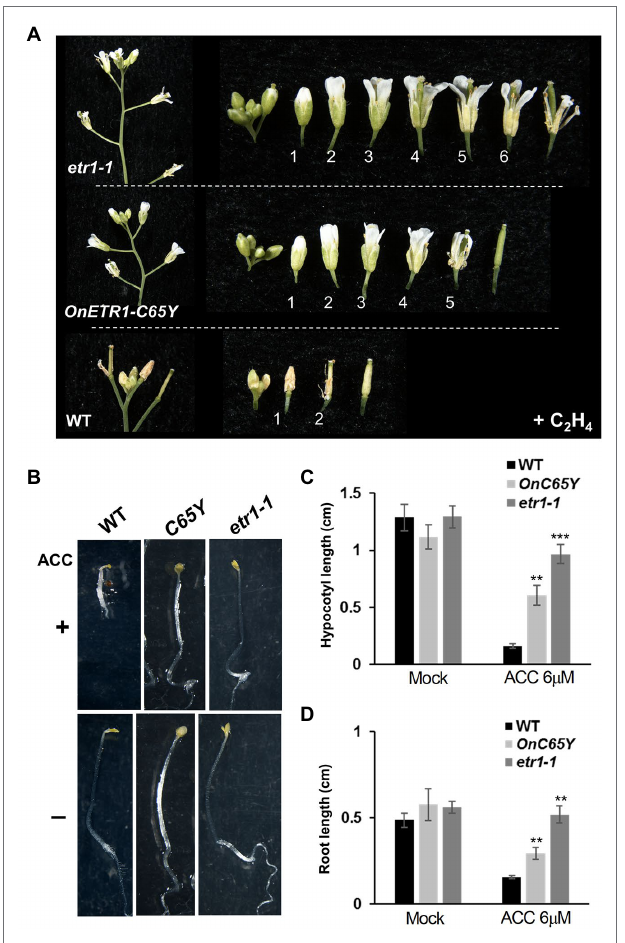
FIGURE 5 | Ethylene treatment and triple response assay in 35S:: OnETR1 - C65Y and etr1-1 Arabidopsis . (A) A comparison of etr1-1 (top), 35S:: OnETR1 - C65Y (middle), and wild-type (bottom) flowers exposed to ethylene (+C 2 H 4 ). In the wild type, the flowers were senescent at position 1, whereas etr1-1 and 35S:: OnETR1 - C65Y flowers were not senescent at positions 5–6 after ethylene treatment. (B) WT, 35S:: OnETR1-C65Y ( C65Y ), and etr1-1 Arabidopsis seedlings were grown on MS plates in the presence (+, top row) or absence ( − , bottom row) of 6 μ M 1-aminocyclopropane-1 carboxylic acid (ACC), the ethylene precursor, for 7 days in the dark. Wild-type seedlings showed apical hooks and short hypocotyls and roots after ACC treatment. Triple response phenotypes were not observed in the etr1-1 or 35S:: OnETR1-C65Y seedlings after ACC treatment. (C,D) Measurement of hypocotyl (C) and root (D) length in wild-type, 35S:: OnETR1-C65Y ( C65Y ) and etr1-1 Arabidopsis seedlings in the presence (ACC 6 μ M) or absence (Mock) of ACC. Values are the average lengths (mean ± SD) of >15 hypocotyls or roots. The error bars represent SD. The asterisks indicate a significant difference from the WT value (** p < 0.01 and *** p < 0.001). Statistical analyses were conducted using two-tailed Student’s t -tests. or JA in the dark for 4 days ( Figure 6A , second to fourth rows, middle and right). Furthermore, chlorophyll remained significantly higher in the detached leaves from 35S:: OnETR1- C65Y and etr1-1 plants than in wild-type plants after dark, ACC or JA treatments ( Figure 6B ). These results indicated that 35S:: OnETR1-C65Y could inhibit leaf senescence by repressing the signal transduction of not only ethylene but also JA.